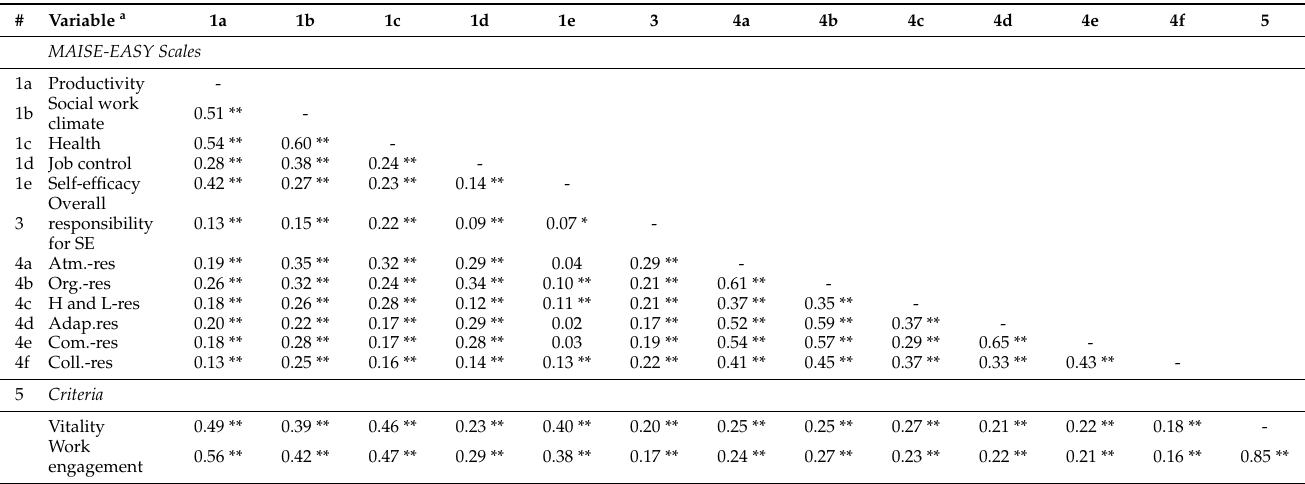
Table 6. Pearson correlations of MAISE-Easy scales and items (N ranges from 1033 to